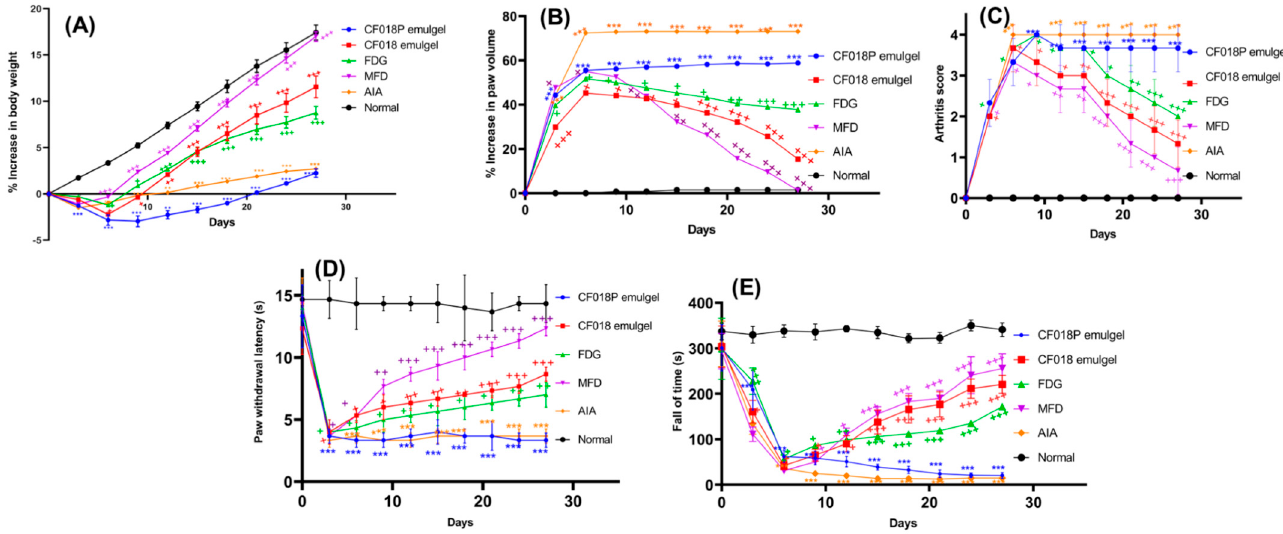
Figure 13. Effect of different formulations on: ( A ) body weight of the rat; ( B ) paw volume of the rat; ( C ) arthritis score; ( D ) paw withdrawal threshold; ( E ) motor incoordination. *** p < 0.001. ** p < 0.01, * p <0.5 vs. normal group; +++ p < 0.001. ++ p < 0.01, + p < 0.5 vs. AIA control .